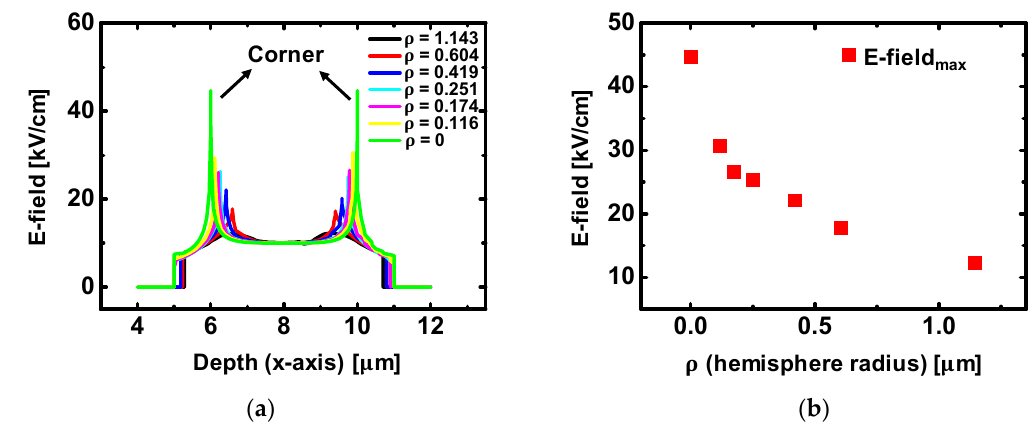
Figure 7. ( a ) E-field variation at Section 1 depending on hemisphere radius ( ρ ) of the channel. ( b ) Extracted maximum field values at the different hemisphere radius.